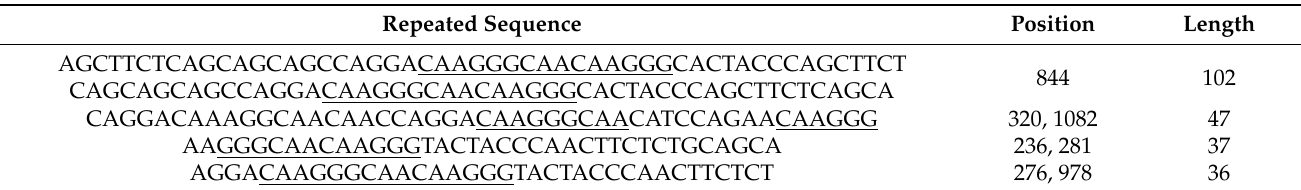
Table 2. The most abundant repeat sequences in TaHMW1D (sequences that experience specific deletion sites after high- temperature stress are underlined).